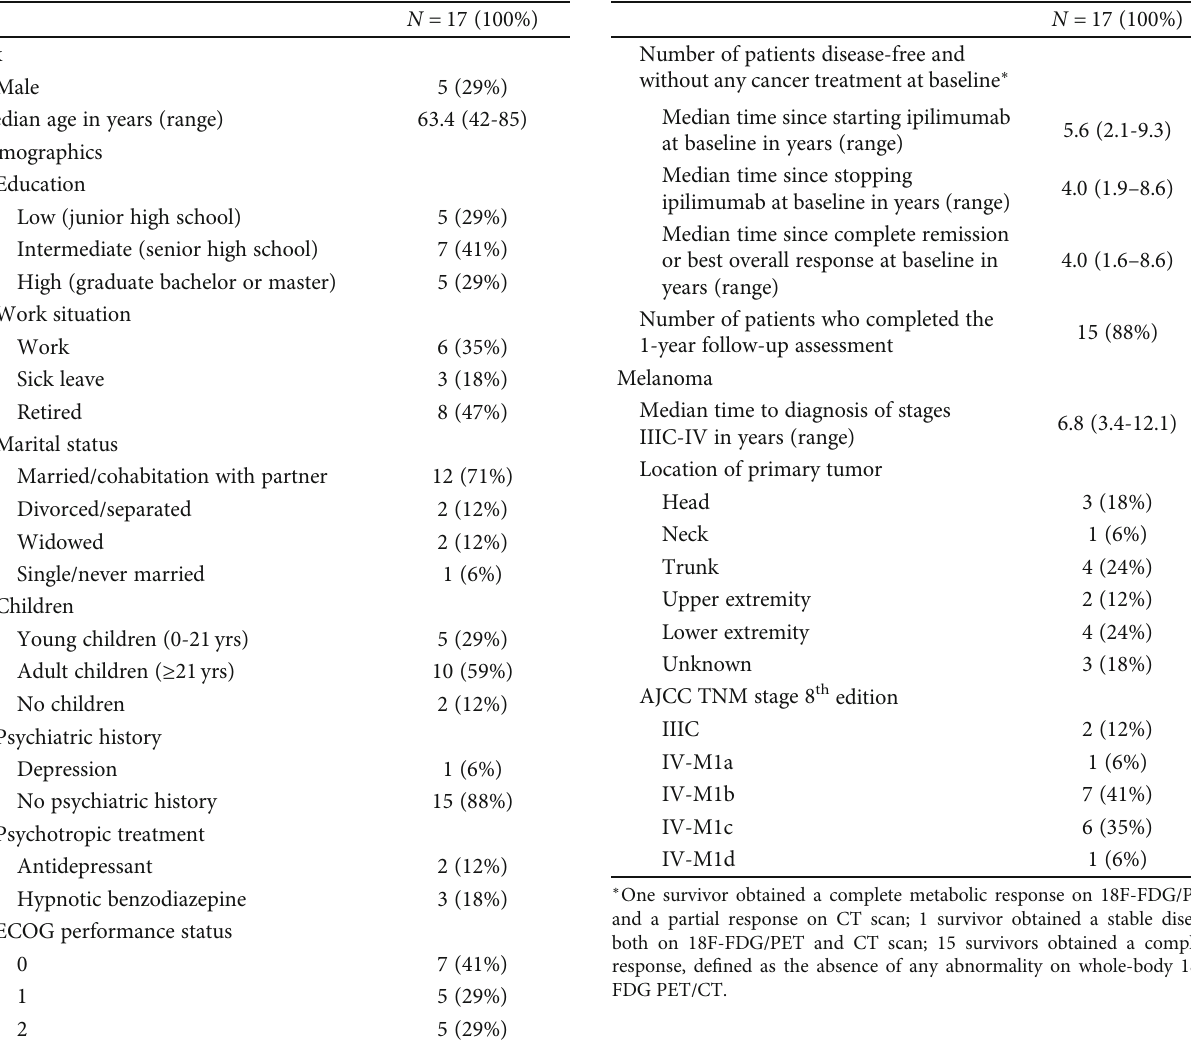
Table 1: Baseline characteristics of the study population. Table 1: